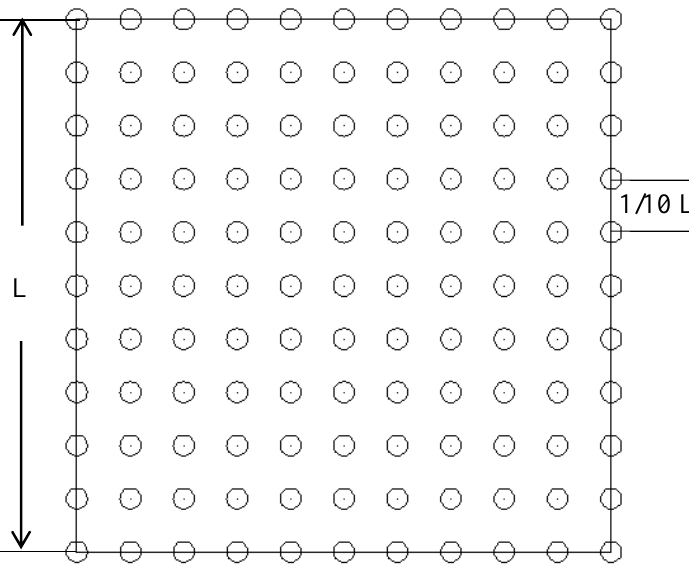
Figure 3. Schematic diagram showing the positioning of measurement poles. (L means the length of the grid).